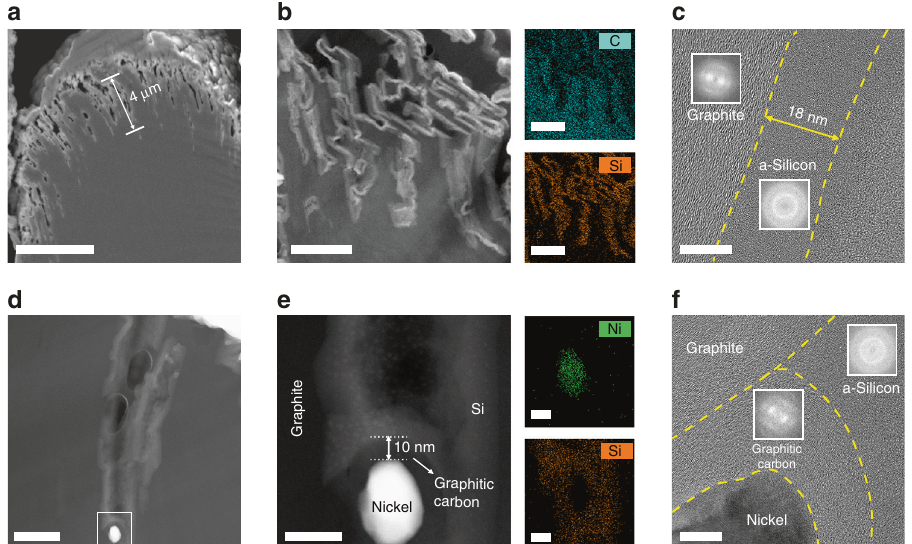
Fig. 3 Detailed investigation of cross-sectional SEAG. a SEM image of SEAG in cross-sectional view: SEAG maintained a rigid inner graphite framework despite going through catalytic hydrogenation. HAADF-STEM images with EDS mapping analysis of b the activated holes and silicon nanolayer on the graphite surface and d the nickel nanoparticle piercing the core of graphite. e Magni fi ed HAADF-STEM image of d . HR-TEM images at the interfacial region of c SEAG and f a nickel nanoparticle; fast Fourier-transform images are shown in the insets. The nickel nanoparticle was clearly separated from silicon by the graphitic carbon shell, which prevented the unfavorable formation of Ni silicide. Scale bars, a 5 μ m, b 1 μ m, c , f 10 nm, d 200 nm, e 30 transmission electron microscope (HAADF-STEM) for detailed increasing the electrode density. The HAADF-STEM image characterization of SEAG (Fig. 3). As shown in the cross-sectional shows the magni fi ed cross-sectional morphology of the SEAG SEM image (Fig. 3a), SEAG retained the sturdy inner graphite (Fig. 3b). Contrary to the dense interior of pristine graphite framework that withstands mechanical pressure even though it (Supplementary Fig. 4), the micrometer-sized holes (average underwent catalytic hydrogenation, which is advantageous for depth of 4 μ m) in SEAG were well arranged on the surface in one